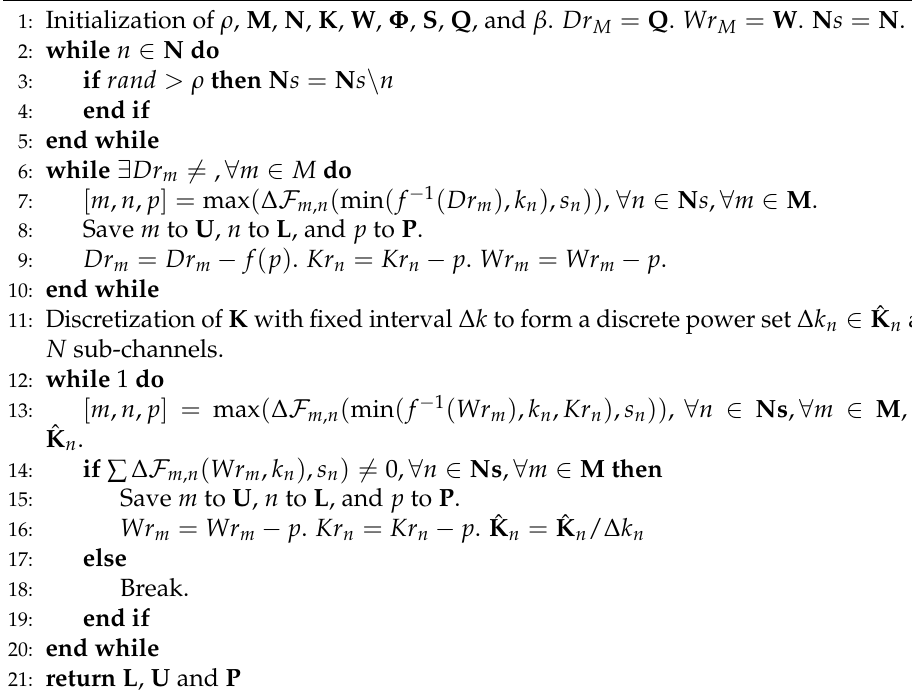
Algorithm 4 Pseudo-code of Stochastic Sample Greedy Algorithm for